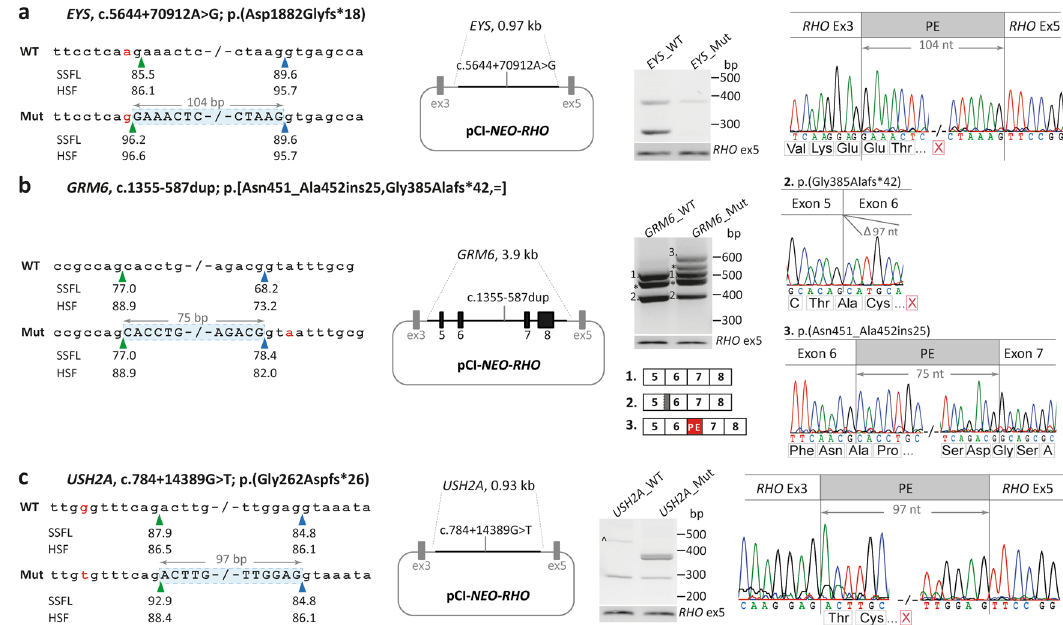
Fig. 3 Splice defects due to deep-intronic variants. For each variant, i.e., a EYS , c.5644 + 70912A>G, b GRM6 , c.1355-587dup, and c USH2A , c.784 + 14389G>T, the left panels are schematic representations of the gene segments of interest containing the corresponding variants in the wild-type (WT) and mutant (Mut) sequences. The SpliceSiteFinder ‐ like (SSFL, range 0 – 100), and Human Splicing Finder (HSF, range 0 – 100) scores for the splice sites are indicated below each sequence. The green and blue triangles indicate the position of splice acceptor sites and splice donor sites in both wild-type and mutant sequences. The red highlighted nucleotides indicate the variants in the mutant sequence. The second panels show the mutant pCI ‐ NEO ‐ RHO vectors. They contain the variants and fl anking exons (except for EYS , as c.5644 + 70912A>G is in a minigene construct) fl anked by RHO exons 3 and 5. Wild-type and mutant constructs were used to transfect HEK293T cells. The next panels show the gel images of RT-PCR products in wild-type and mutant midi- or minigenes. RT ‐ PCR analysis of RHO exon 5 was performed as a control for transfection ef fi ciencies. For the GRM6 c.1355-587dup variant, the asterisks in the gel image indicate the heteroduplex fragments. For the USH2A c.784 + 14389G>T variant, the “ ^ ” in the wild-type construct indicates an artifact product. In the last panels, the Sanger sequence analysis of the RT ‐ PCR fragments con fi rmed the predicted splice defects for each variant. For GRM6 c.1355-587dup, the sequence of fragment 2 in both midigenes showed the 97-bp deletion of exon 6, which led to the frameshift variant. The third fragment was only observed in the mutant construct and corresponded to the insertion of an in-frame pseudoexon in intron 6. The red “ X ” in a red box indicates the stop codon in each schematic chromatogram. For each variant, both WT and mutant variants were examined in parallel in the same experiment and processed in